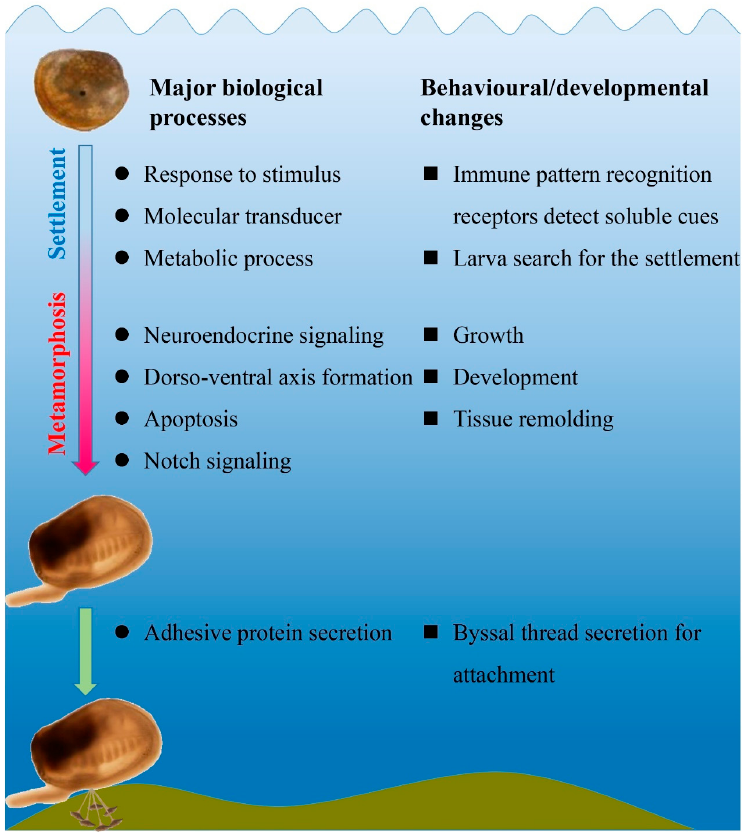
Figure 6. A schematic depiction of a larval settlement and metamorphosis model based on the genes identified by RNA-seq.